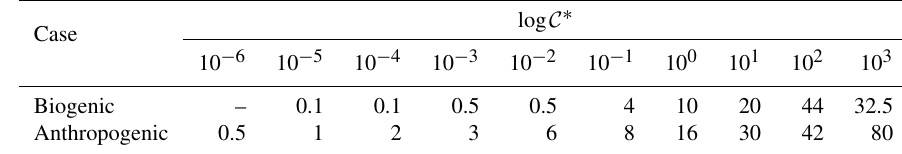
Table 3. Volatility distributions used to represent typical biogenic and anthropogenic SVOC concentrations. These values are rescaled in order to obtain the required organic mass fraction in the simulations. Concentrations are given in × 10 − 2 µgm − 3 .